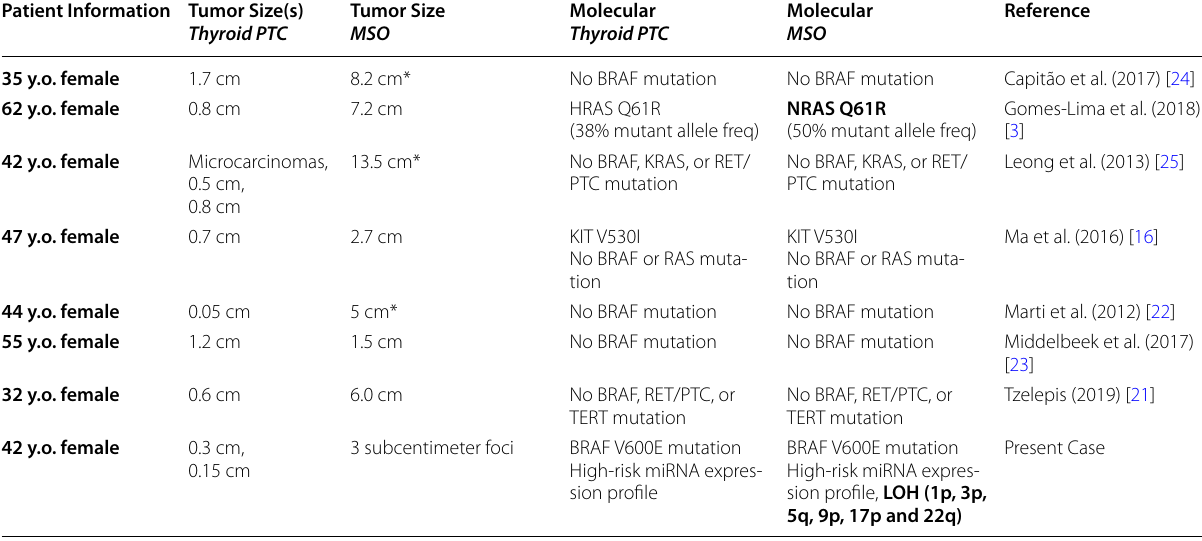
* Asterisk denotes size of ovary in the absence of PTC size data; Discordant LOH findings emphasized in bold